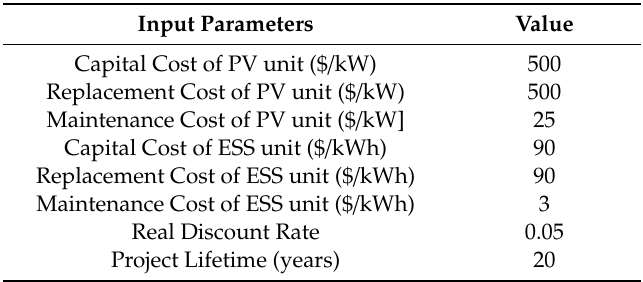
Table 2. Economic input parameters for PV and ESS units.